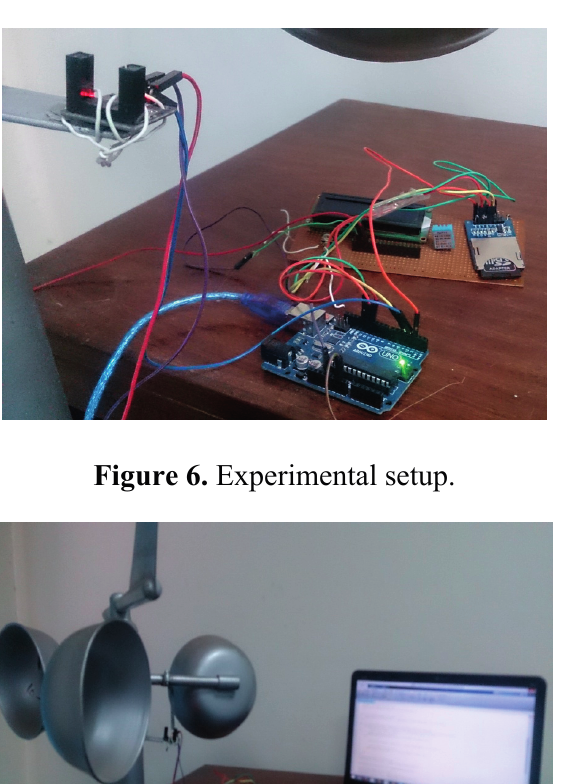
Figure 5. Experimental setup.